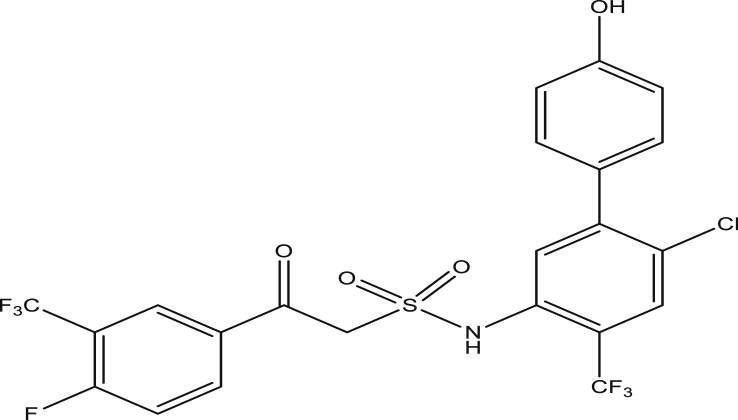
Compound 9l [N-(6-chloro-4′-hydroxy-4-(trifluoromethyl)-[1,1′-biphenyl]-3-yl)-2-(4-fluoro-3-(trifluoromethyl)phenyl)-2-oxoethanesulfonamide (pEC500.396291)].